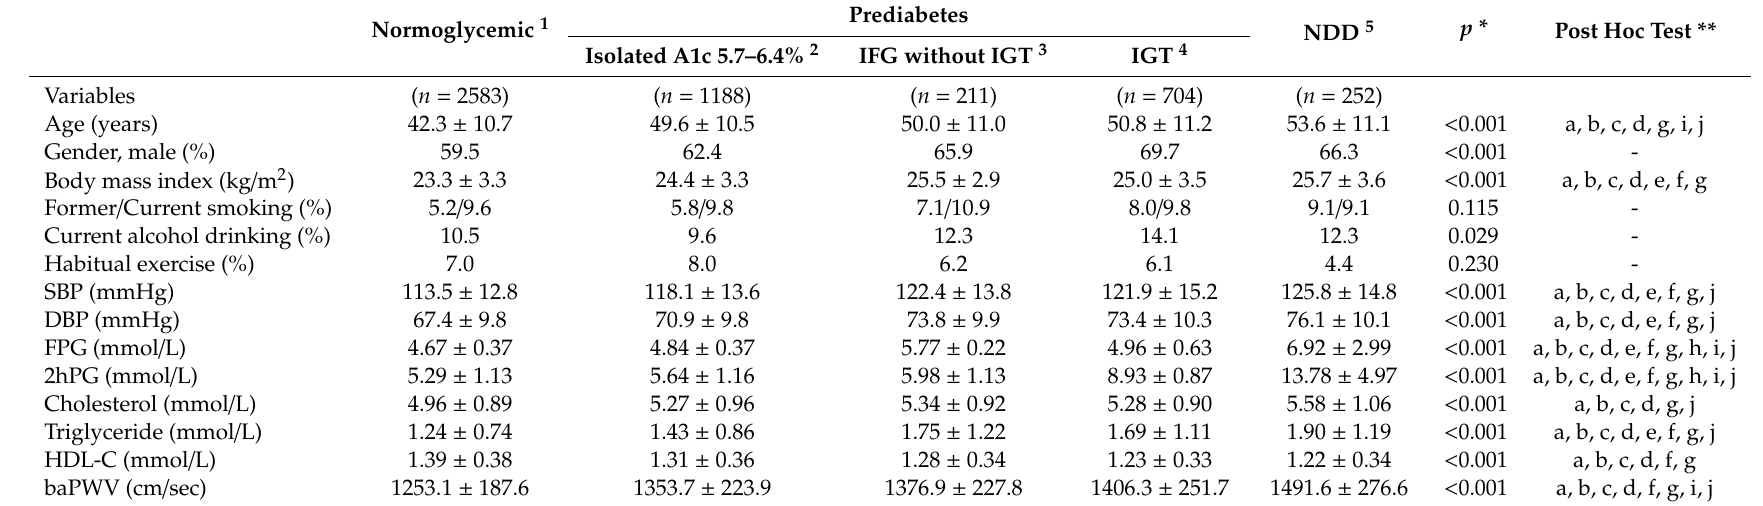
Table 1. Demographic and clinical characteristics of study subjects with di ff ering glycemic statuses according to A1c, FPG, and 2hPG. Normoglycemic